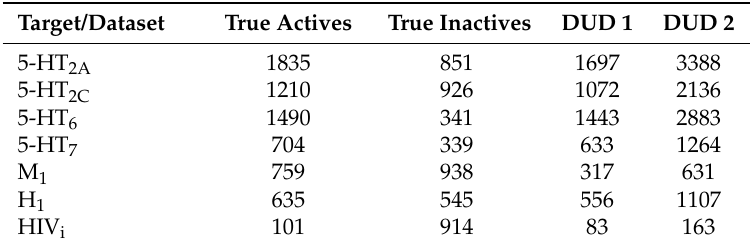
Table 1. The number of compounds present in a particular